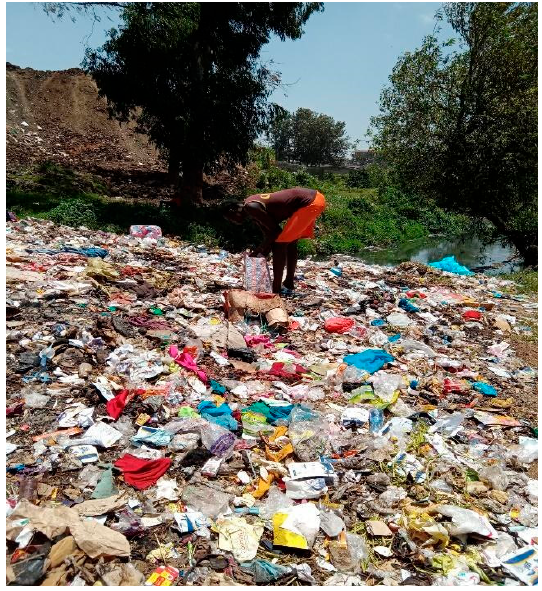
Figure 5. “This is the dumpsite. When we go there we don’t wear gloves because we cannot afford [them] so we have to touch everything. Sometimes we end up touching faeces because that is waste from people’s households. You can even get diseases there. In this picture, I’m at the dump site because some of the waste dumped there is from abroad and that is where COVID is prevalent. So you can end up touching someone’s mask then you forget and touch your face. You see in that situation you may end up getting COVID, so we are at high risk. Sometimes I get sick also—back aches and coughing—because I wake up very early in the morning” (Violet, 17-year-old girl, Korogocho).